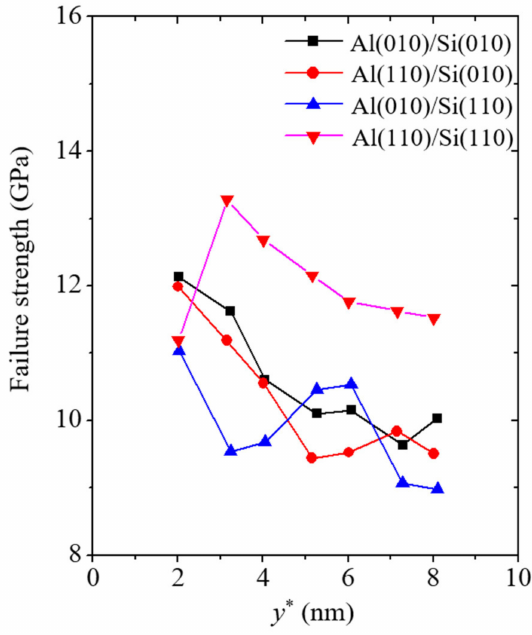
Figure 6. Failure strength corresponding to the varying thicknesses of Al nanofilm denoted by the variable y *.